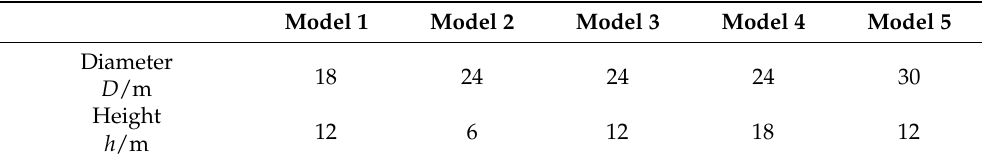
Table 5. Parameters of model bucket.